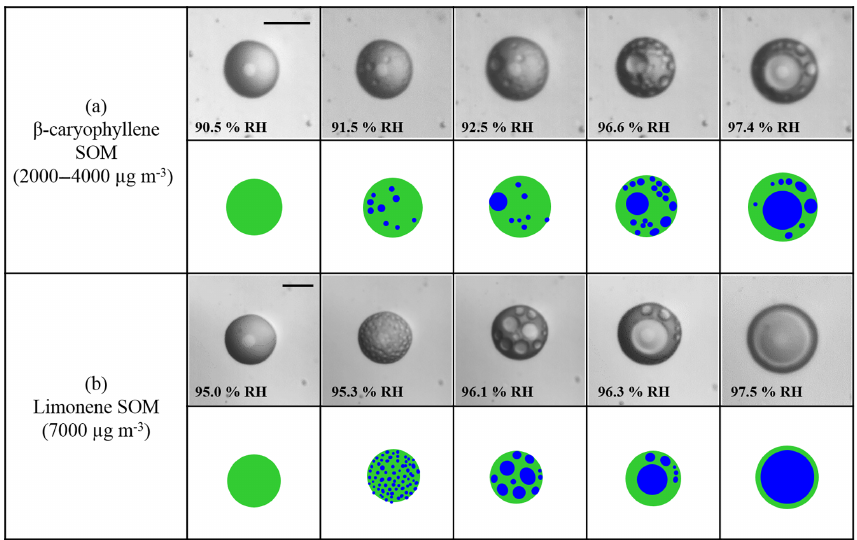
Figure 1. Optical images of SOM particles with increasing RH: (a) β -caryophyllene-derived SOM for the mass concentrations of 2000– 4000µgm − 3 ( β -caryophyllene 3, Table 1) and (b) limonene-derived SOM for the mass concentrations of 7000µgm − 3 (limonene 3, Table 1). Note that the light gray circles at the center of the particles are an optical effect due to the hemispherical nature of the particles. Illustrations are shown below the images for clarity. Green: SOM-rich phase. Blue: water-rich phase. The scale bar is